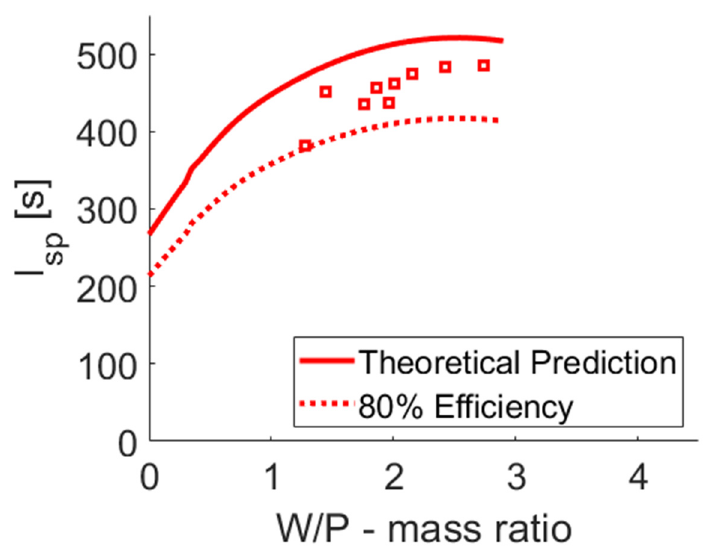
Figure 8. Theoretical and static firing test results of the standard specific impulse vs. the water– propellant mass ratio for a hybrid-propellant, water-breathing ramjet fueled with 70% polyester and 30% magnesium.